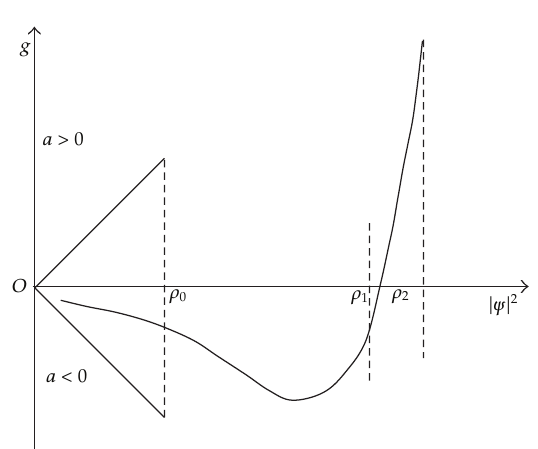
Figure 3: E ff ects of the s-wave scattering and the van der Waals interaction.